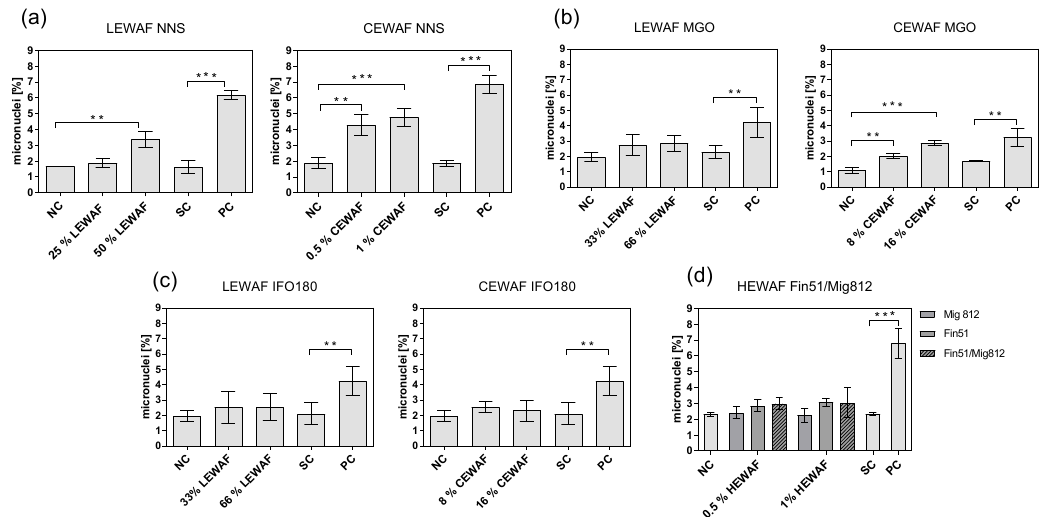
Figure 3. Micronucleus induction in ZF-L cells exposed to WAF dilutions of crude oil (NNS, a ) and refined petroleum products (MGO, b , IFO 180, c ) as well as dispersant combinations (HEWAF, d ). The dispersant Finasol OSR 51 ® was tested in corresponding concentrations to the NNS CEWAF treatment. Bars represent the mean percentage of micronucleated cells (out of 2000 counted cells) with error bars indicating the standard deviation ( n = 3–4). Negative- (NC), solvent- (SC, 0.1% DMSO) and positive (PC, 4-Nitrochinolin-1-oxide, 0.1% DMSO) controls were included. Chi 2 test with Yates correction was used for statistical analysis. Asterisks indicate significantly higher micronuclei induction compared to controls (** p < 0.01, *** p < 0.001). All data met the validity criteria (NC micronuclei < 3%,